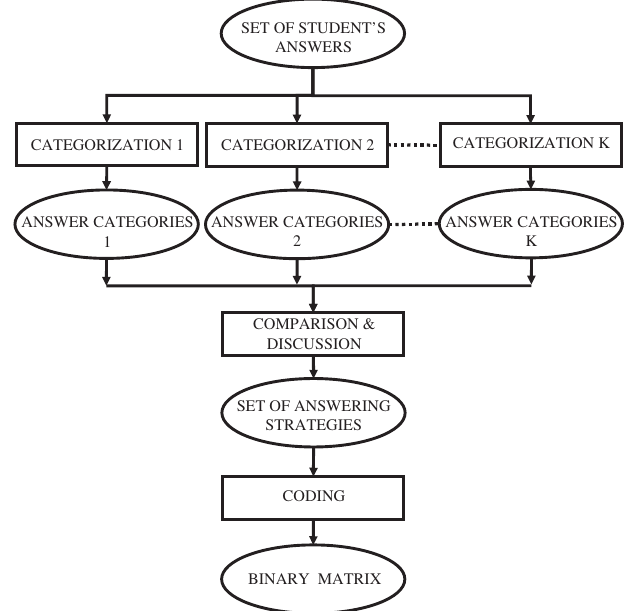
FIG. 1. Flow chart of the steps that can be followed by k researchers when processing data coming from student answers to an open-ended